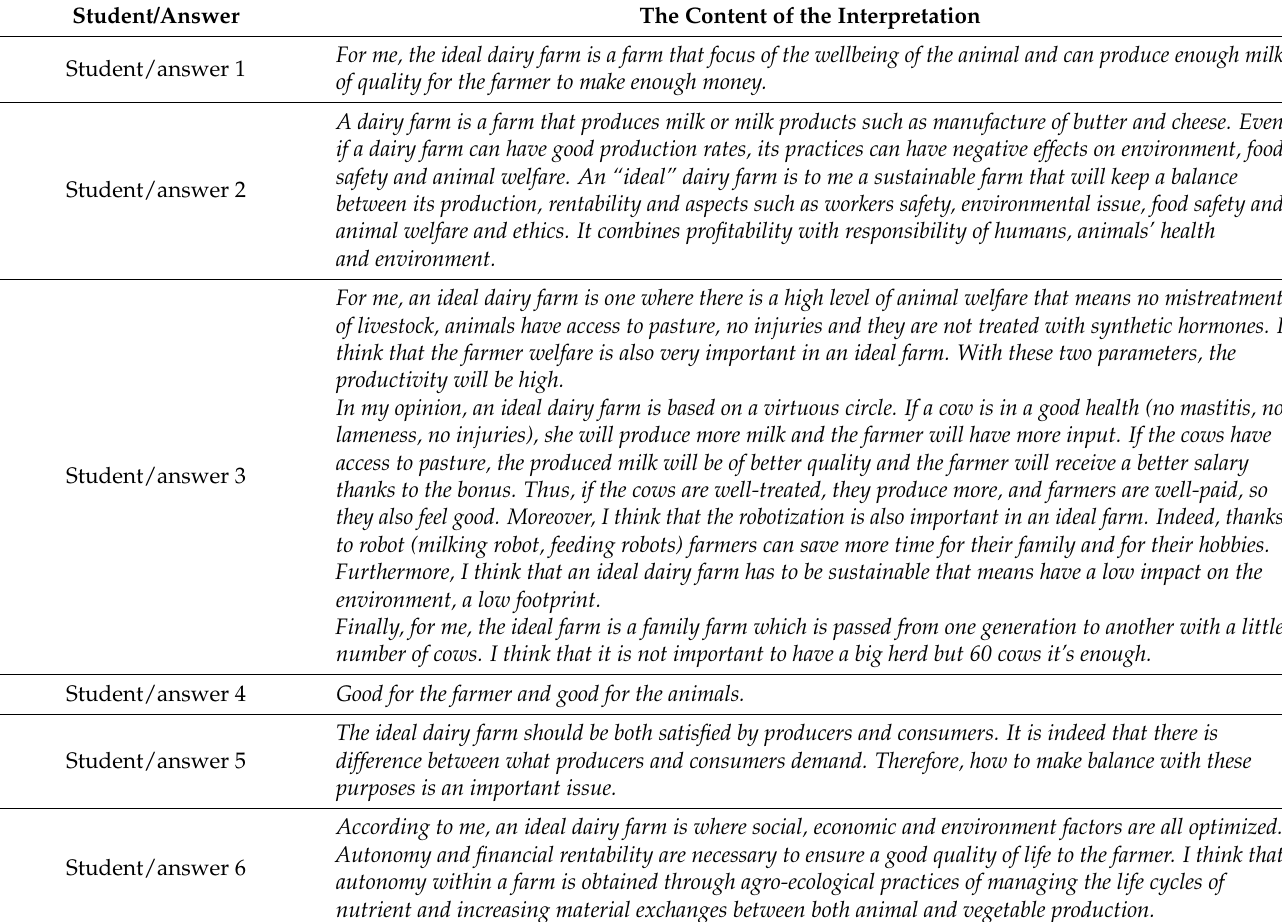
Table 1. Interpretation of the term ideal dairy farm: answers prepared by Erasmus+ students. The Content of the